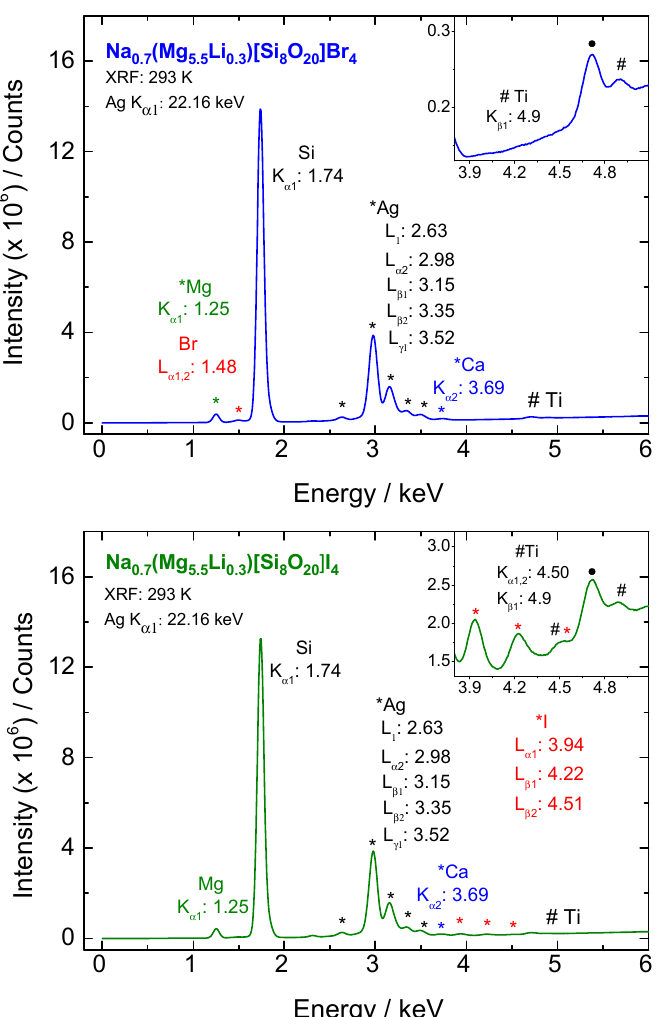
Figure 2. The XRF spectra of bromohectorite ( top ) and iodohectorite ( bottom ). The upper insertions show the presence of Ti impurities in both materials (•: instrumental signal).